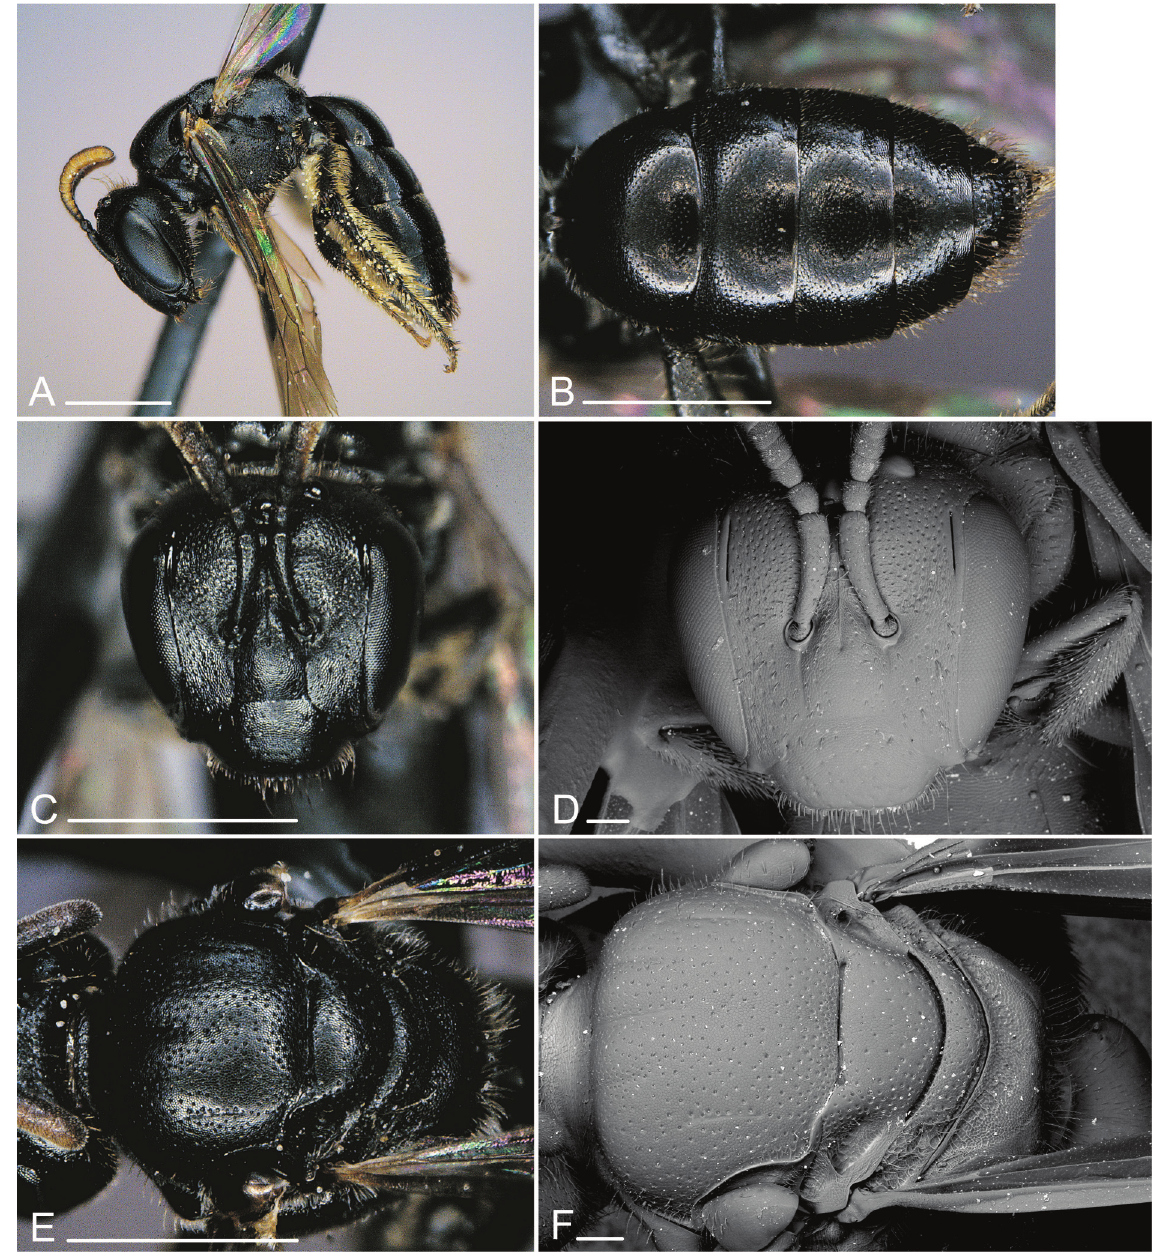
Fig. 10. Scrapter inexpectatus sp. nov., ♀. A . Lateral view. B . Metasoma (dorsal view). C . Head. D . Head (SEM). E . Thorax (dorsal view). F . Thorax (dorsal view, SEM). Scale bars: photos: 1 mm, SEM: